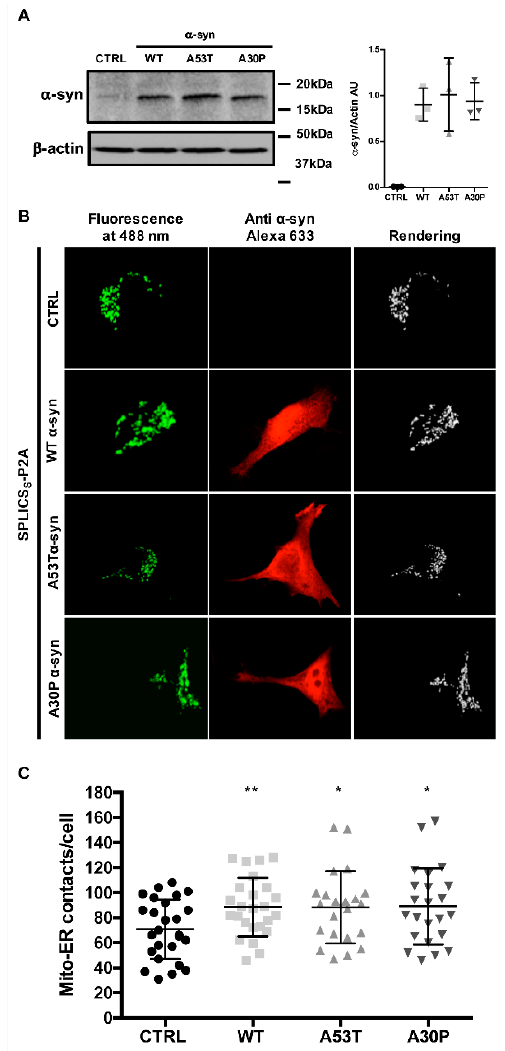
Figure 1. α -syn A53T and A30P mutants physically modulate ER-mitochondria contact sites. ( A ) HeLa cells were transfected with wt, A53T, and A30P α -syn expression plasmids and analyzed by Western blotting with an anti α -syn antibody. Equal loading was verified by probing the membrane with an anti β -actin antibody. Quantification of three independent experiments ( B ) HeLa cells were co-transfected with wt, A53T and A30P α -syn expression vectors and the SPLICS S sensor to assess short-range ER-mitochondria associations. Reconstitution of the fluorescent signal was observed upon 488 nm wavelength excitation in α -syn positive cells probed with an anti α -syn primary antibody and revealed by an Alexa 633 secondary antibody. The 3D rendering of the Z-stacks acquired for the SPLICS S probe is shown on the right. ( C ) Quantification of the ER-mitochondria contact sites / cell in the di ff erent conditions is shown as mean ± SD. *, p < 0.05, **, p < 0.01. One-way ANOVA test retrieved a p -value of 0.04. Unpaired Student’s two-tailed t -test was used for two-group comparison. No correction was applied since the same SD was assumed. Dunnet’s post-test was also applied to compare wt and α -syn mutants each other but no significance was detected. The asterisks refer to Student’s two-tailed t -test where the comparison was for each independent sample vs. mock